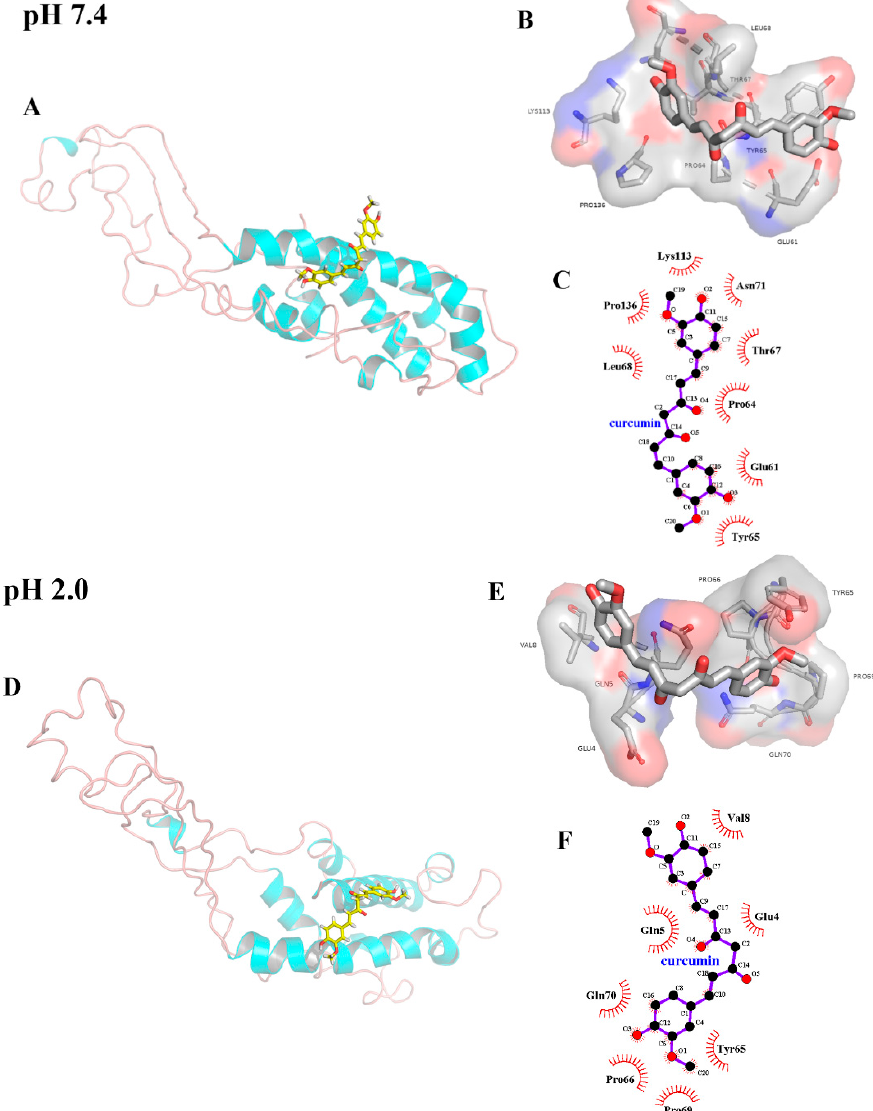
Figure 4. 3D image of the best binding pose for curcumin docked into the β -casein at pH 7.4 ( A ) and pH 2.0 ( D ), 3D characterization of the interacted residues between curcumin and β -casein at pH 7.4 ( B ) and pH 2.0 ( E ), and 2D characterization of the interacted residues between curcumin and β -casein at pH 7.4 ( C ) and pH 2.0 ( F ).